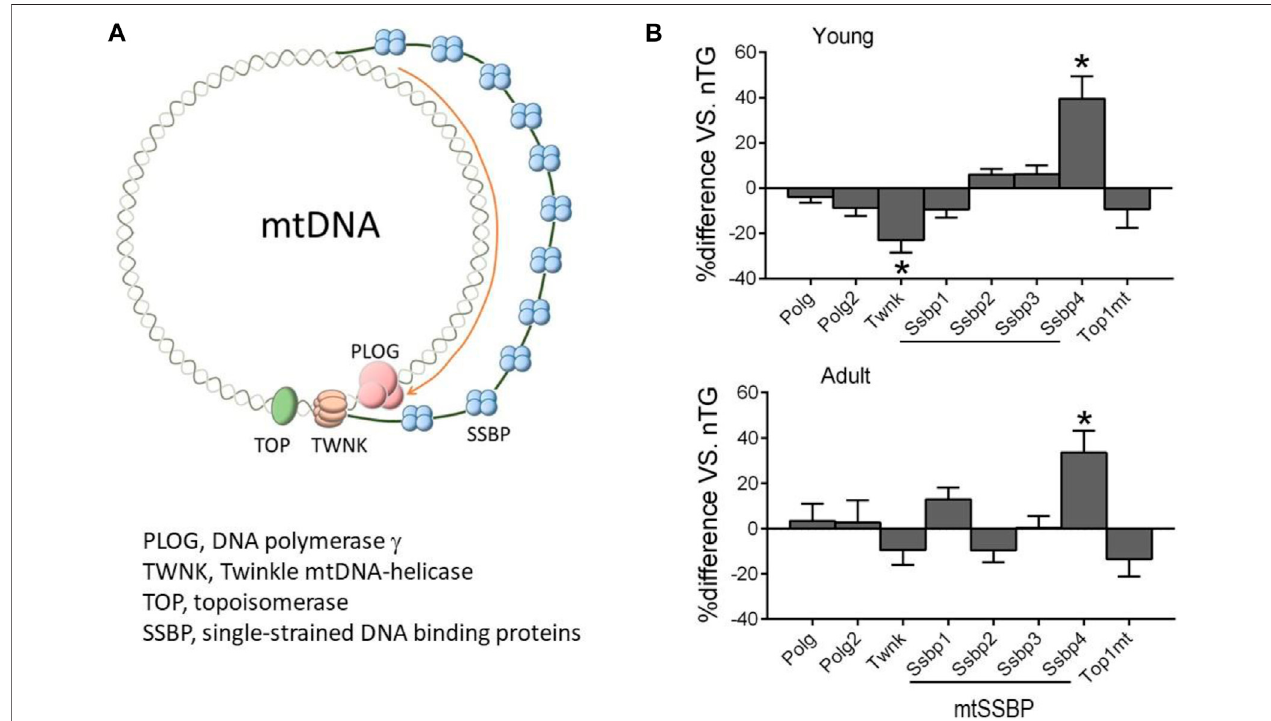
FIGURE 6 | Expression of nDNA-encoded genes forming mtDNA replisome. (A) Diagram illustrating factors involved in mtDNA replication. (B) Relative expression of genes of mtDNA replisome in DCM hearts of young and adult mice. * p < 0.05 vs. respective control.